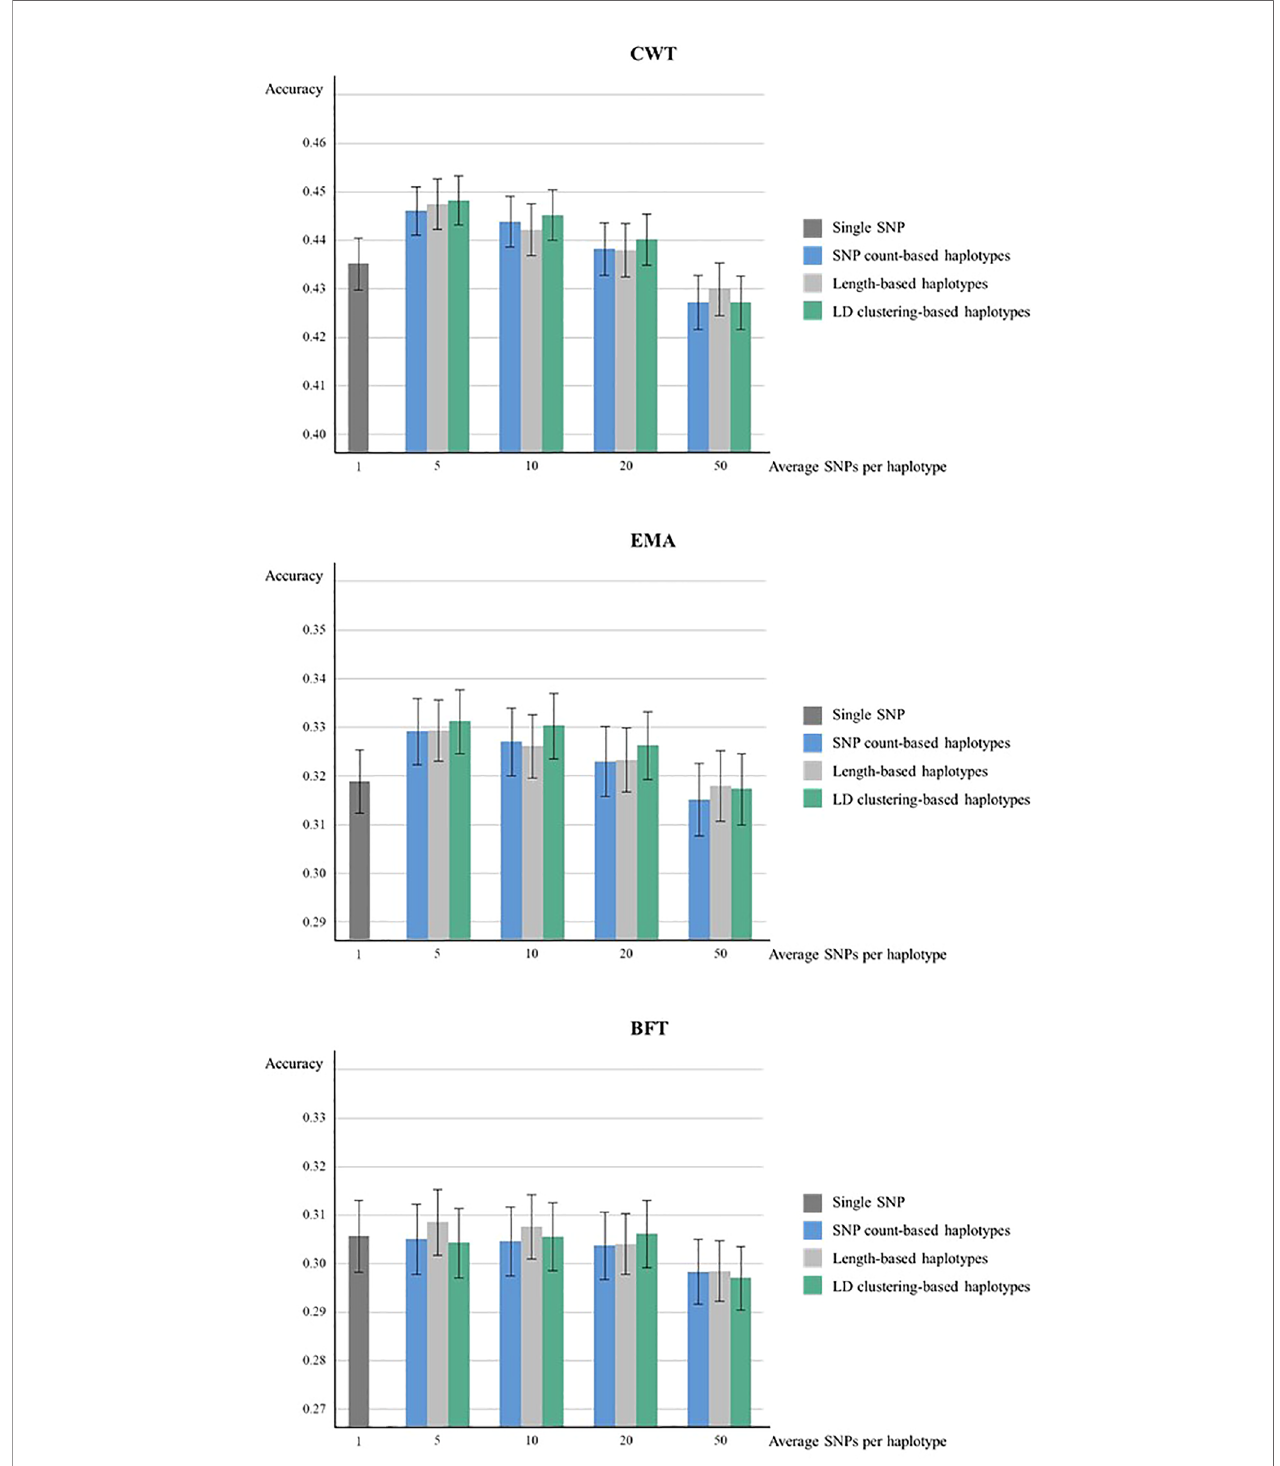
FIGURE 1 | Genomic prediction accuracies from fi ve time fi ve-fold cross validation. Prediction accuracies of using various sizes of haplotypes de fi ned by different methods and using individual SNPs were compared for CWT, BFT and EMA respectively. The black lines on the bars show standard errors of the prediction accuracies. Accuracies were calculated as the correlation coef fi cients of GEBVs and pre-corrected